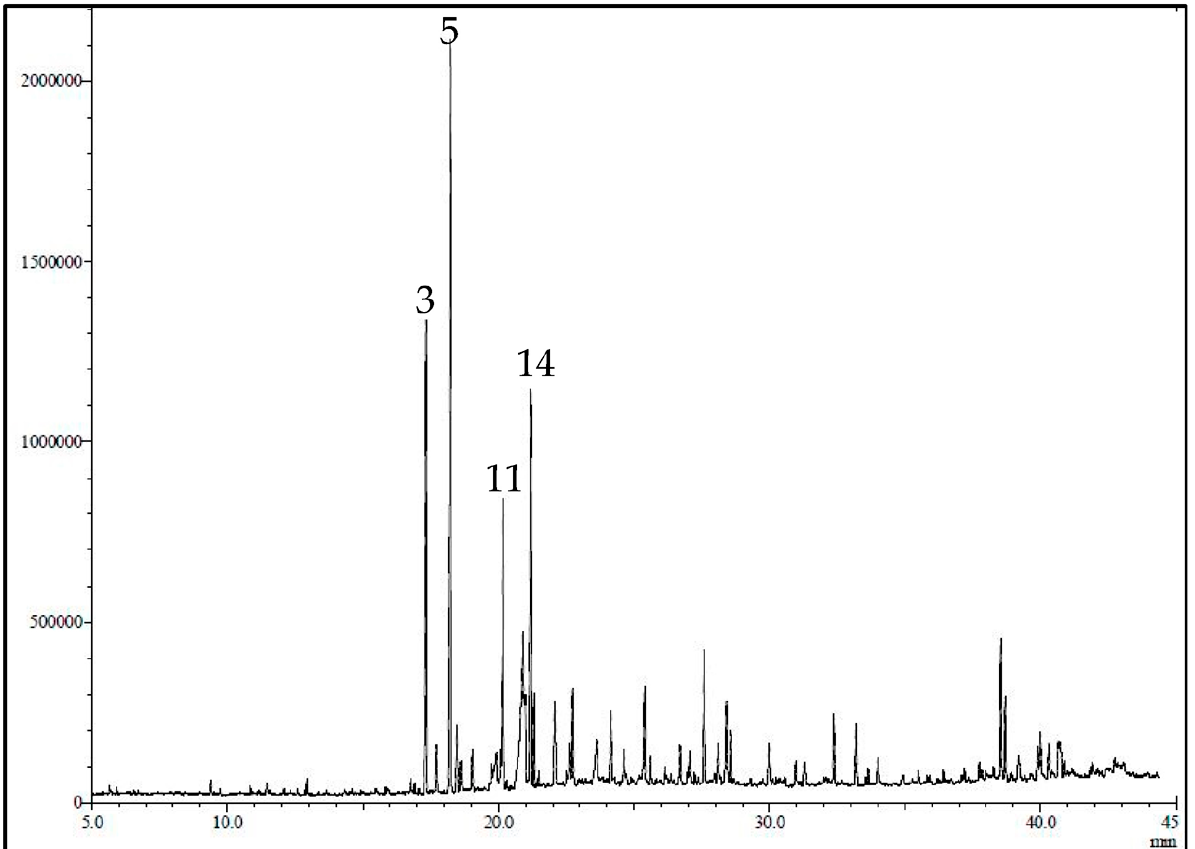
essential oil of the leaves of C. citrates, representing 95.29% of the total oil composition (Table 1). In the current work, α -citral (18.50%), β -citral (10.15%), geranyl acetate (9.65%),